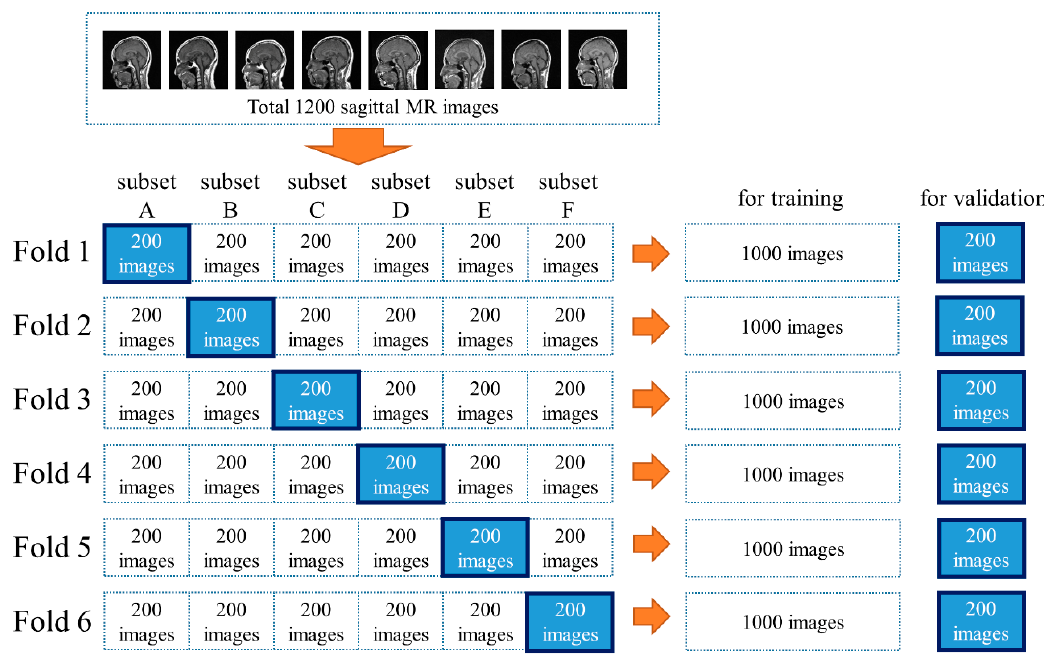
Figure 2. A total of 1200 images were divided into six subsets to complete the six-fold cross-validation.